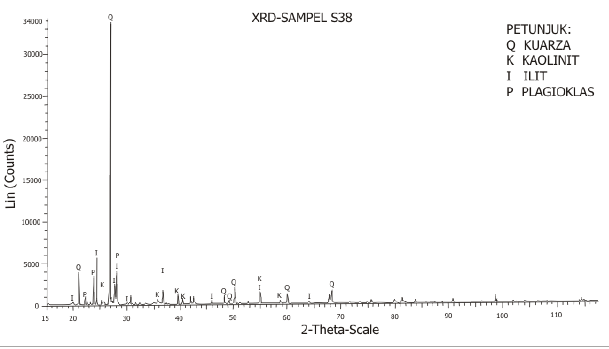
Sandstone porosity in the study area varies from 11% to 13% with an average 12% (Table 3). In case of petrographic analysis, porosity is highest in the well sorted, low matrix environment. Thin section and SEM photomicrographs indicate two pore types are present. These are intergranular and micro pores. Both primary and secondary intergranular pore types are present in most of the samples. In